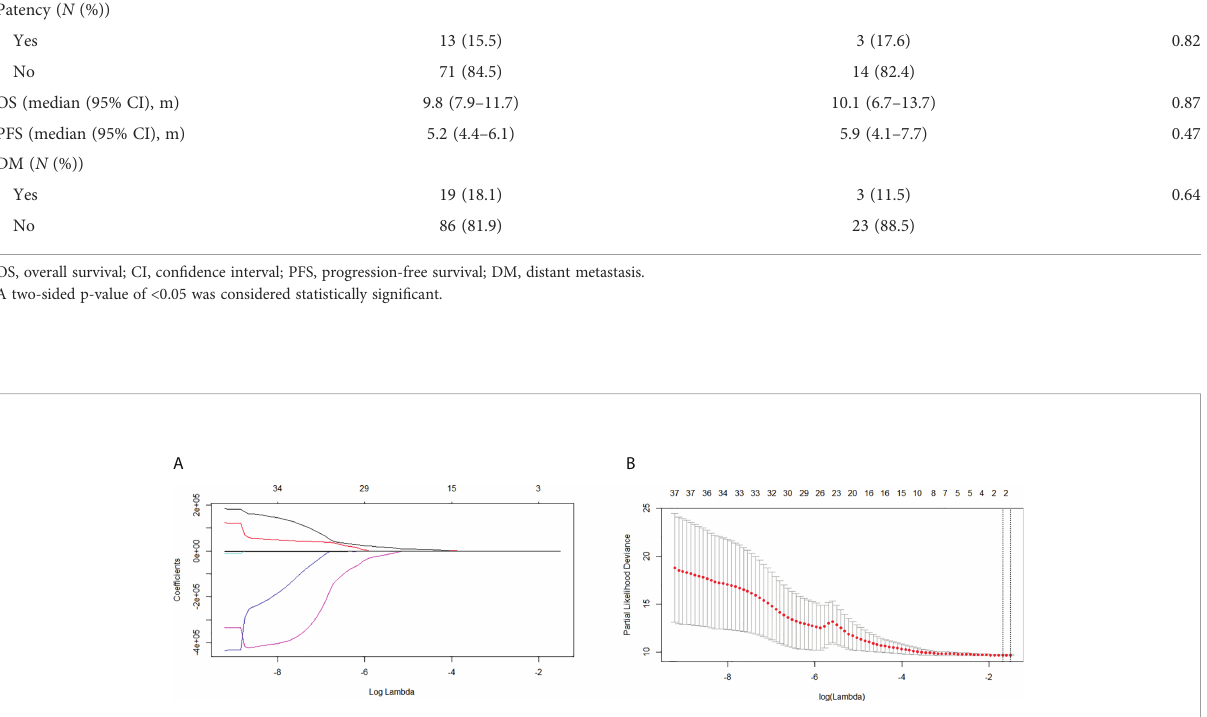
FIGURE 3 Least absolute shrinkage and selection operator (LASSO) regression analysis for the selection of signi fi cant radiomics features from the 48 textural features. (A) Coef fi cient pro fi le of the LASSO model. (B) Optimal tuning parameter (lambda) selection using 10-fold cross-validation with minimum criteria. Two signi fi cant radiomics features were